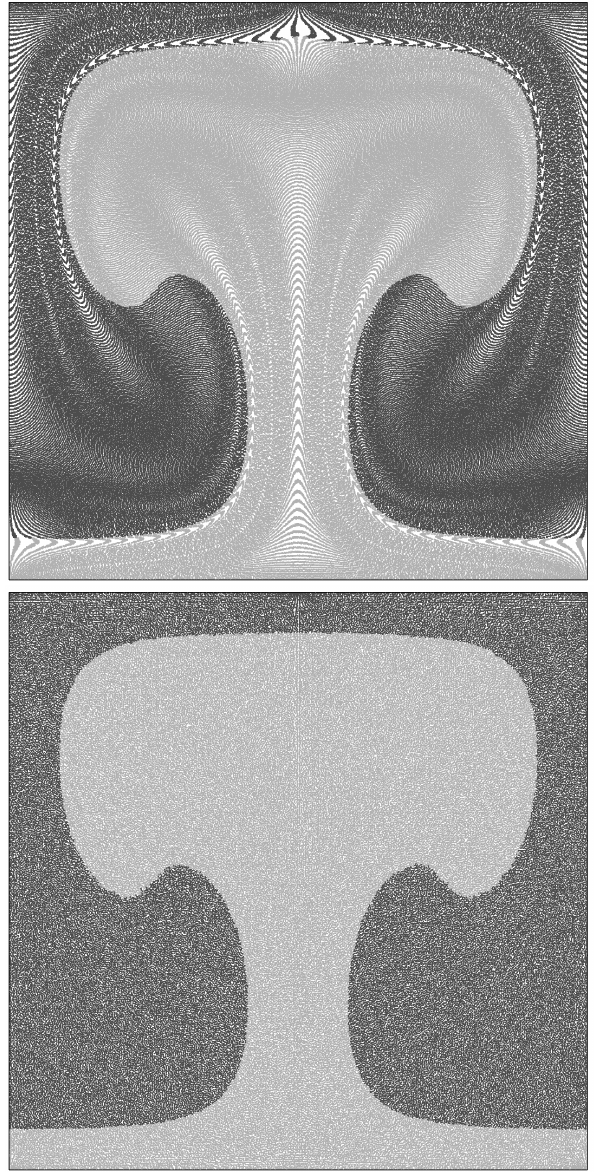
Figure 34. Effect of the Voronoi tessellation algorithm on a Lagrangian particle distribution. The tessellation is disabled ( top )/enabled ( bottom